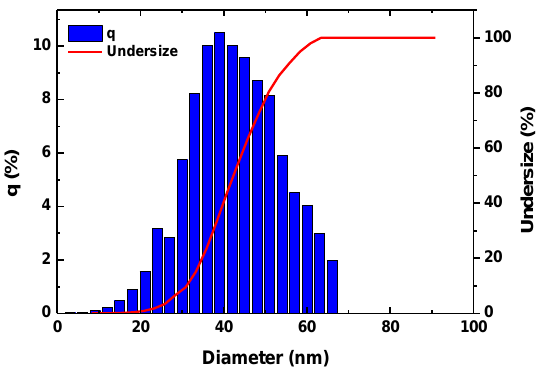
Figure 1. Schematic of the particle size distribution of the TiO 2 diffuser.